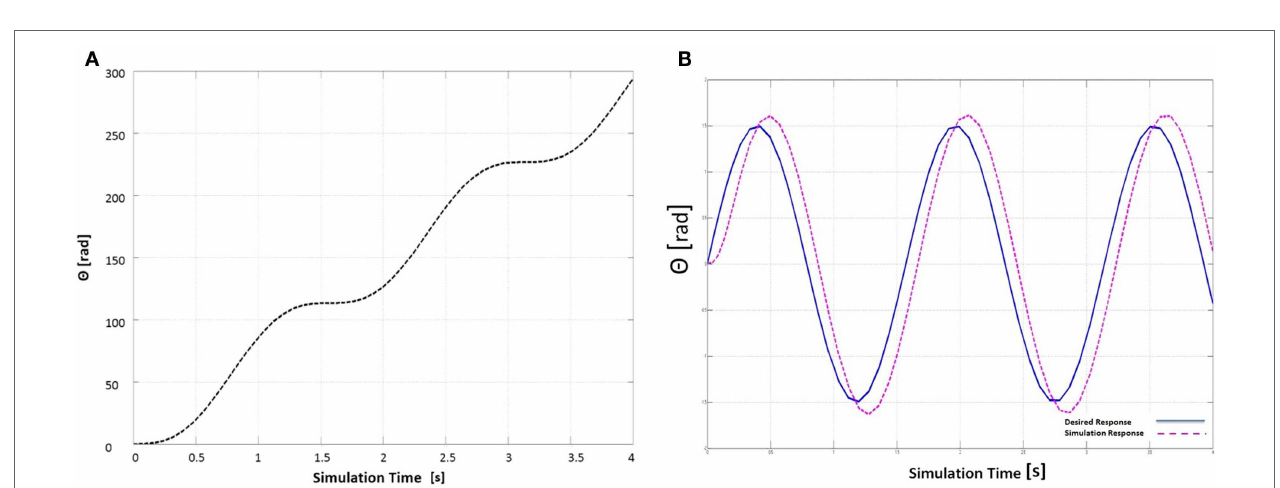
FIGURE 5 | Simulation model for the pitch rotation mechanism with a PID control using the calculated transfer function .